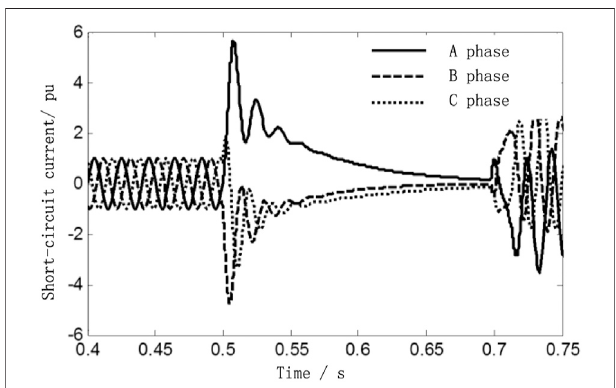
FIGURE 7 | DFIG short circuit current value of three-phase short circuit at bus C under rated operating conditions.